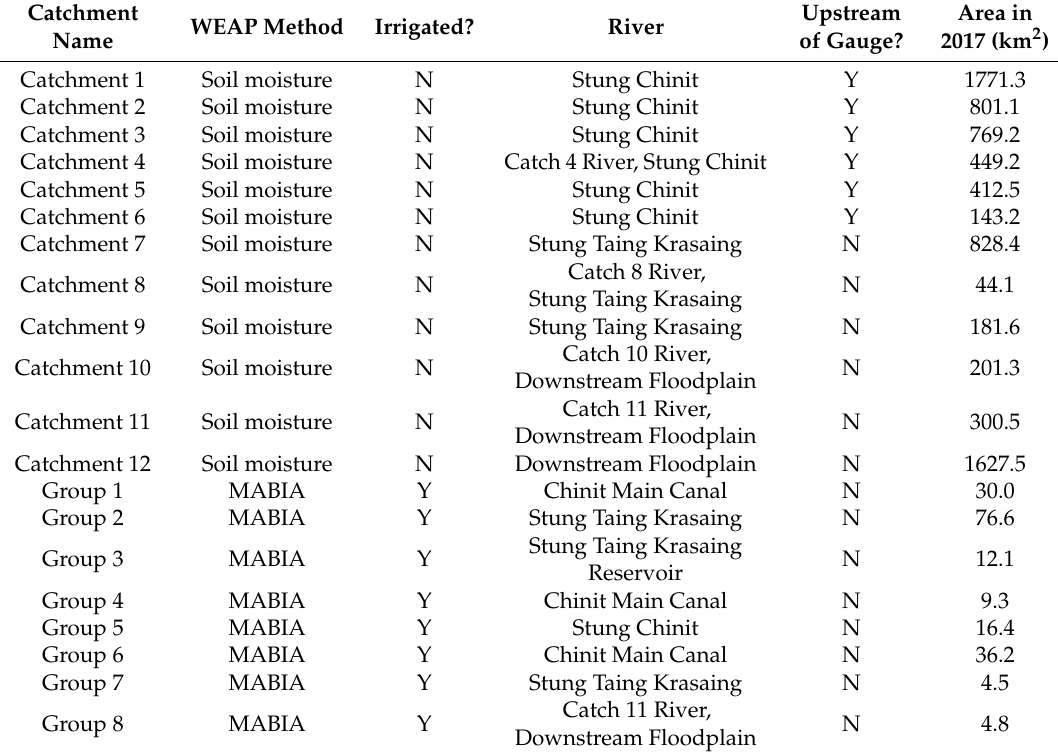
Table A1. Characteristics of 20 catchments in the Stung Chinit model, the WEAP method used to calculate rainfall-runo ff and irrigation demand, whether or not the catchment is irrigated, the river the catchment contributes to (primarily, secondarily, if it does not contribute directly to one of the main rivers), whether or not it is upstream of the streamflow gauge and its area in 2017.